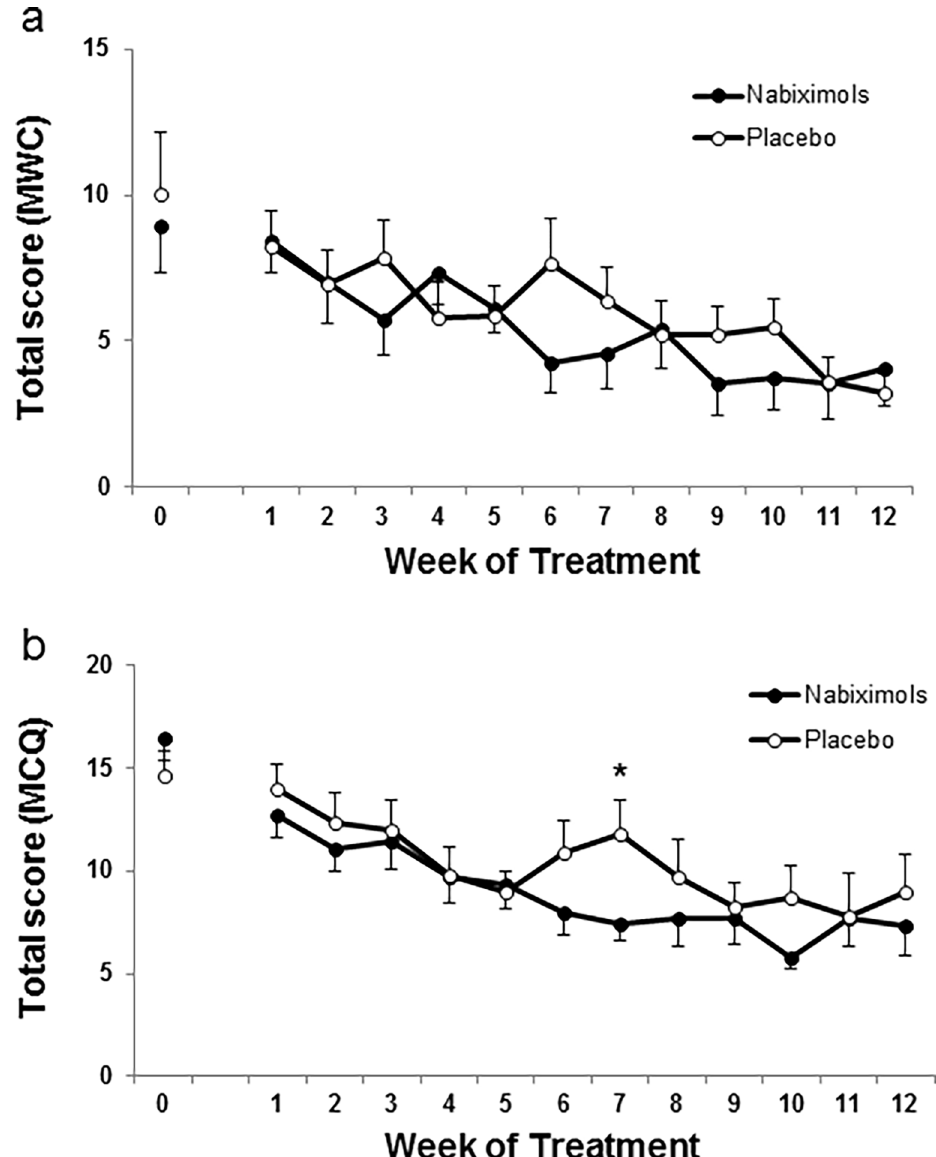
Fig 4. Cannabis craving and withdrawal. Circles (white placebo, black nabiximols) represent mean (+SEM). In a) cannabis withdrawal from the Cannabis Withdrawal Checklist (CWC). In b) craving for cannabis from the Marijuana Craving Questionnaire (MCQ). Generalized Linear Mixed Model (GLMM) analyses followed by one-way ANOVA, (cid:3) (p < .05) vs nabiximols group.